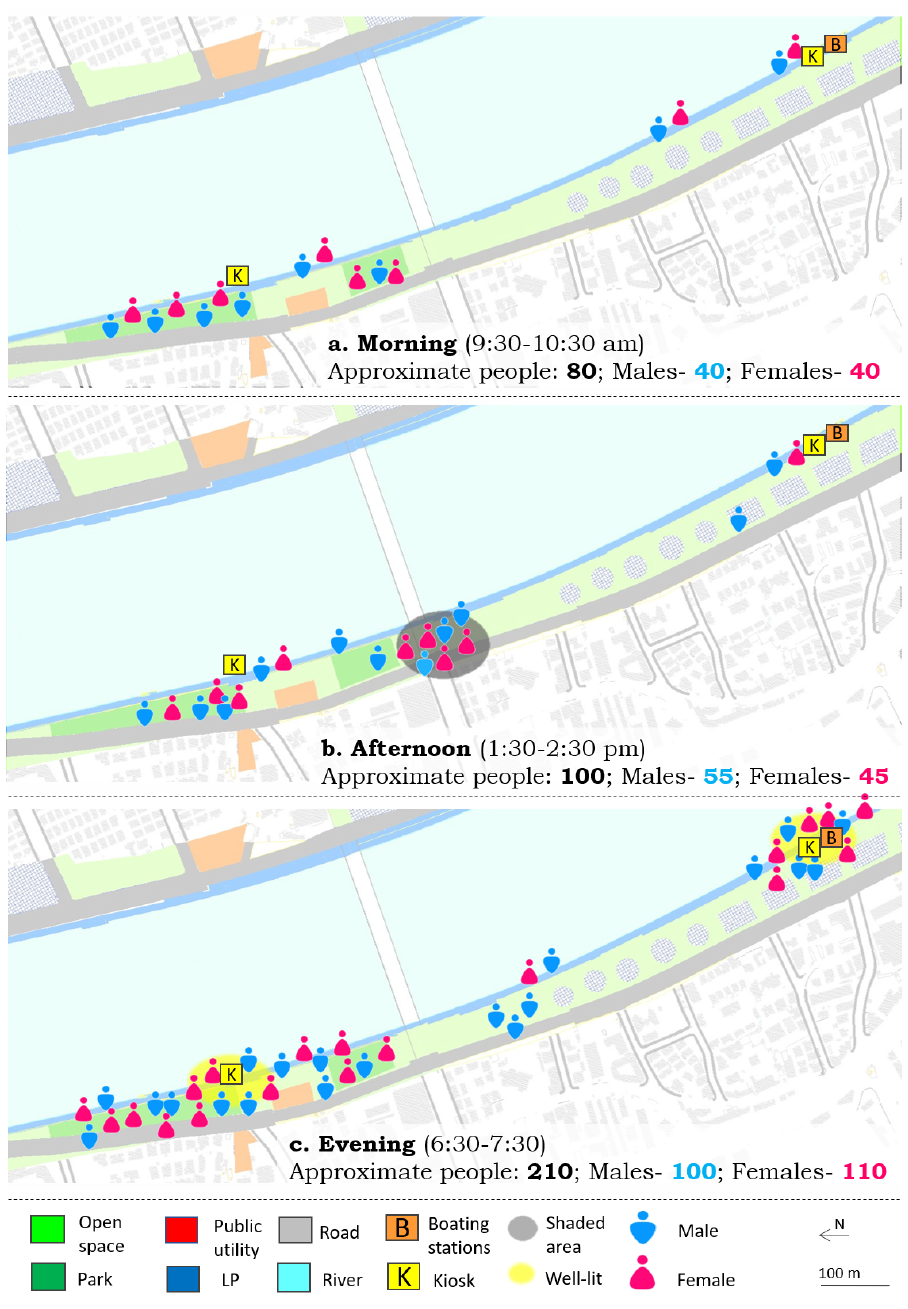
Figure 3. Gendered usage of space in Pocket 1. this segment of the riverbank always accompanied by friends or